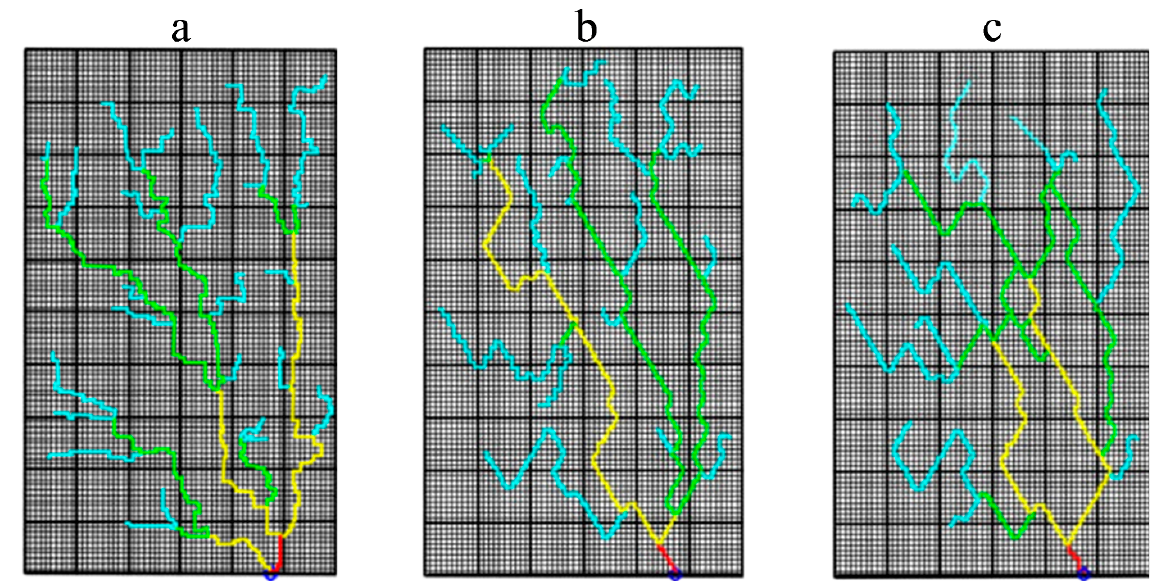
Figure 8. Three types of conduit patterns used in scenario A. ( a ) Curvilinear branchwork. ( b ) Rectilinear branchwork. ( c ) Network maze.